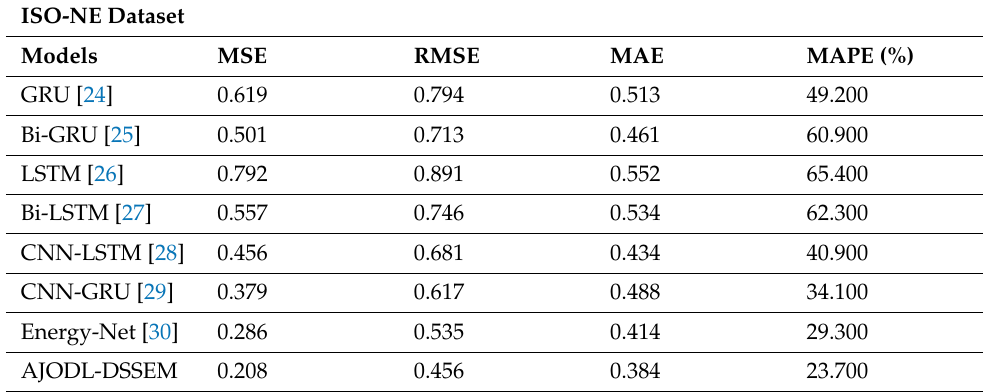
Table 5. Comparative analysis of AJODL-DSSEM algorithm with recent methodologies under ISO- NE